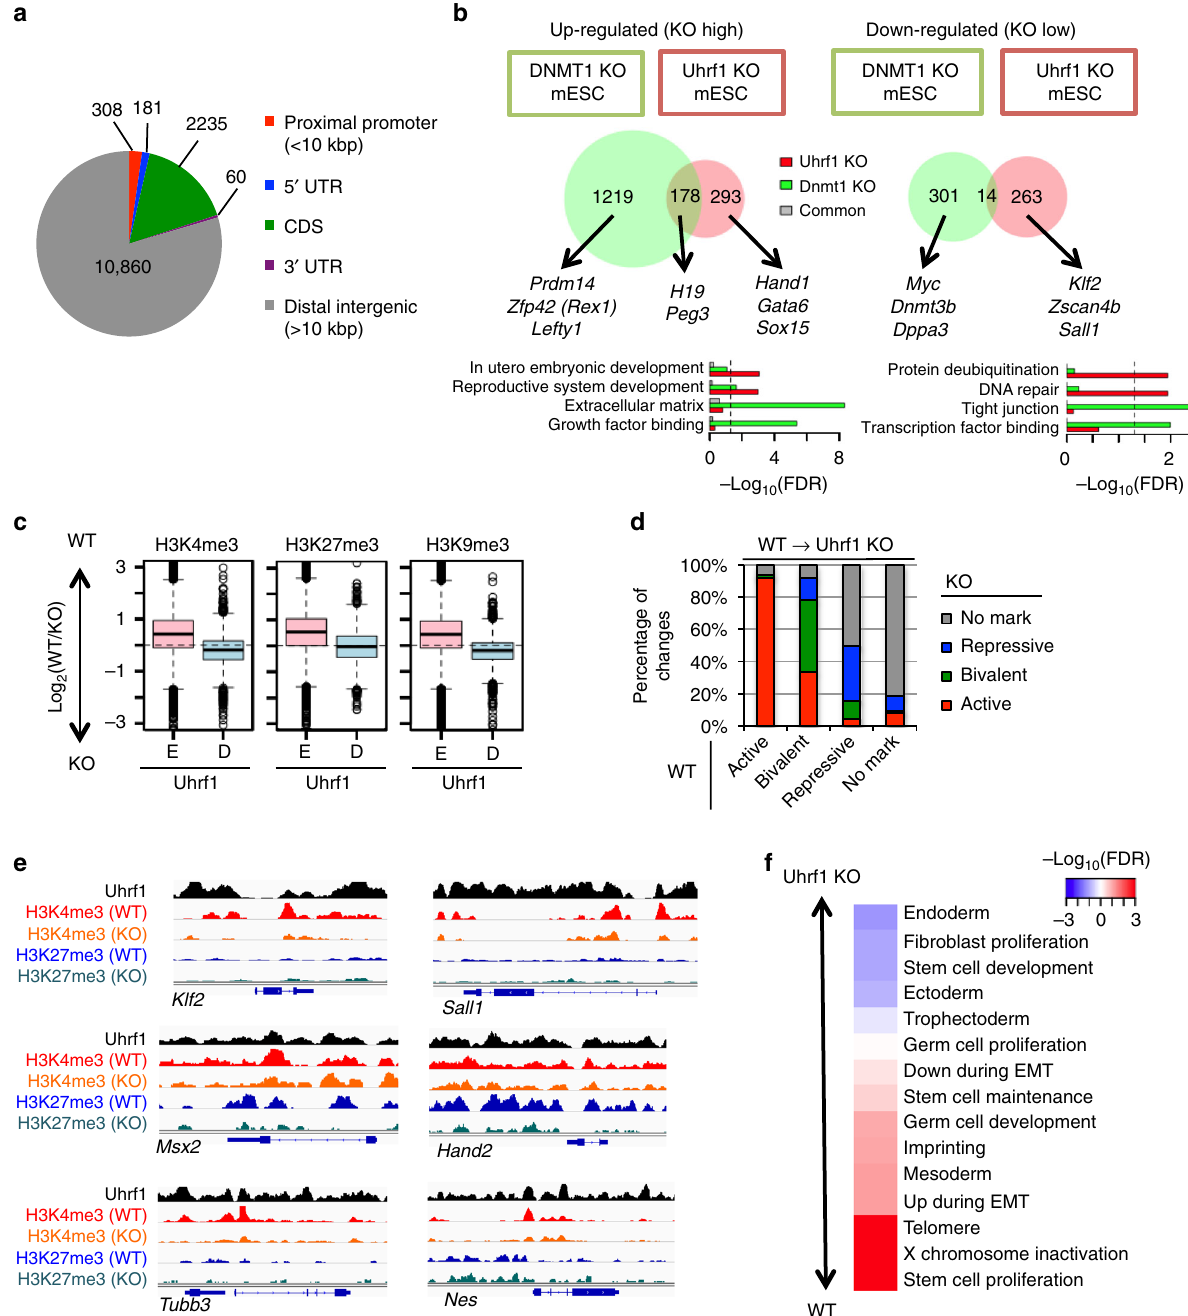
Fig. 1 Uhrf1 de fi ciency disrupts bivalent histone modi fi cation. a Distribution of Uhrf1-enriched regions in gene body and intergenic regions. b Comparative analysis of up-regulated (left) and down-regulated genes (right) between Uhrf1 and Dnmt1 KO. Representative genes and over represented GO terms for unique and common genes are also shown. Dashed line represents 0.05 FDR cut-off. c Comparative analysis of H3K4me3, H3K27me3, and H3K9me3 change between Uhrf1-enriched ( e ) and Uhrf1-depleted ( d ) regions. Y -axis represents the difference of log 2 (ChIP/input) between WT and Uhrf1 KO. d Changes of promoter classes between WT and Uhrf1 KO ESCs. e Histone modi fi cation landscape of representative genes related to pluripotency, mesoderm/mesenchyme/muscle, and neuroectoderm development. f GSEA for stem cell functions. Statistical enrichment ( − log 10 (FDR)) in Uhrf1 KO and WT was shown by blue and red color,